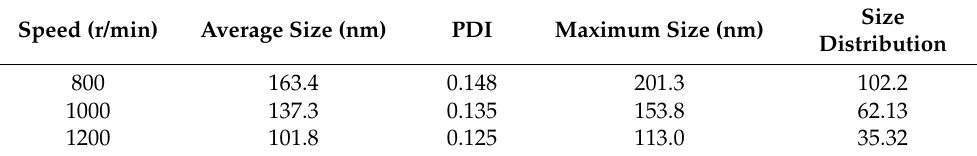
Table 2. Single-factor investigation: particle size.